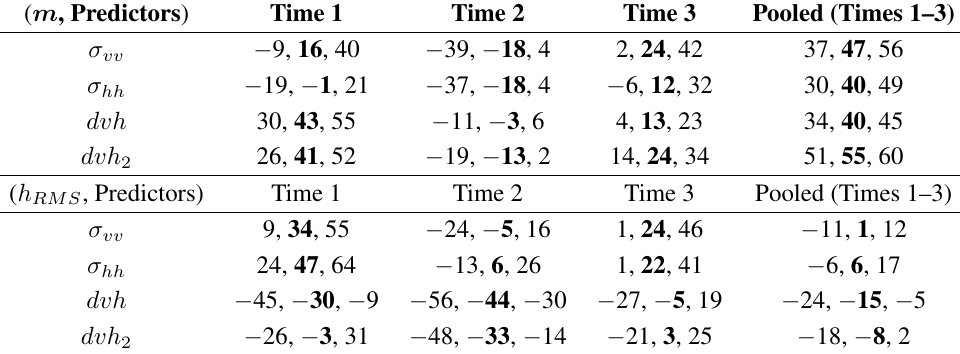
Table 4. Correlation (%) between in-situ soil moisture ( m )(%) and surface roughness ( h (cm) with the four leading model predictors ( σ vv , σ hh , dvh, dvh 2 ), respectively. Uncertainty in these correlation estimates was estimated from standard statistical bootstrapping based on 1000 bootstrap samples. The 10th, 50th (median) and 90th quantiles are indicated, respectively, with the median values highlighted in